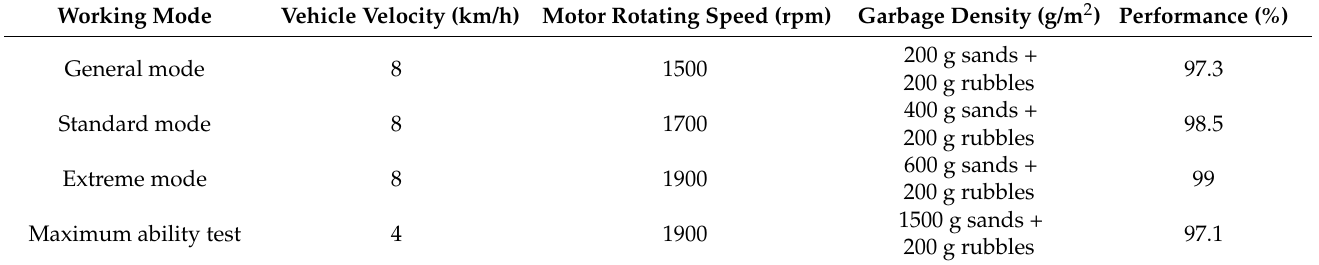
Table 3. Experiment